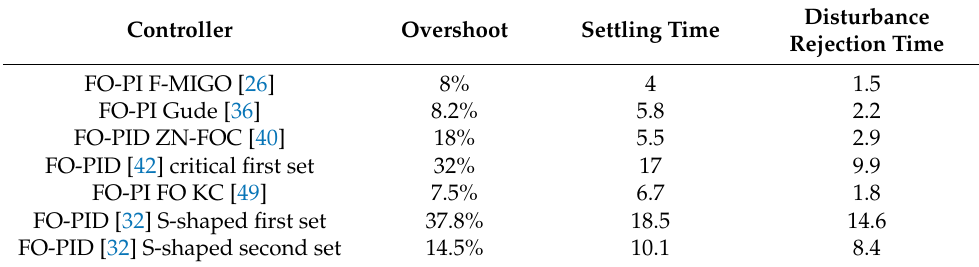
Table 10. FO-PID parameters computed for the poorly damped process.